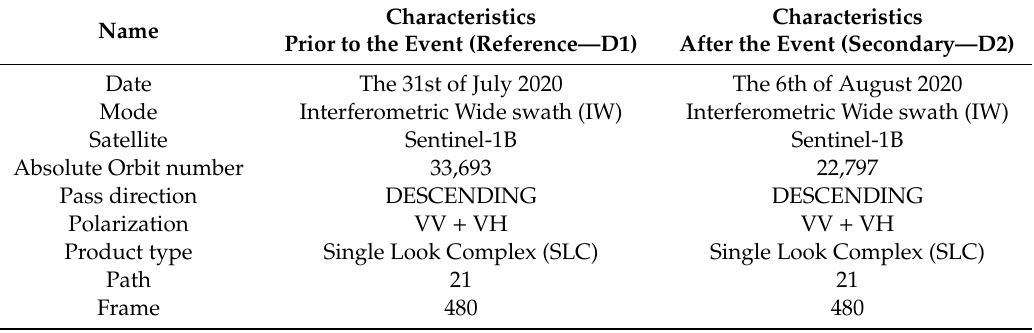
Table 2. Sentinel-1 data used for the Interferometric Synthetic Aperture Radar (InSAR) analysis (descending